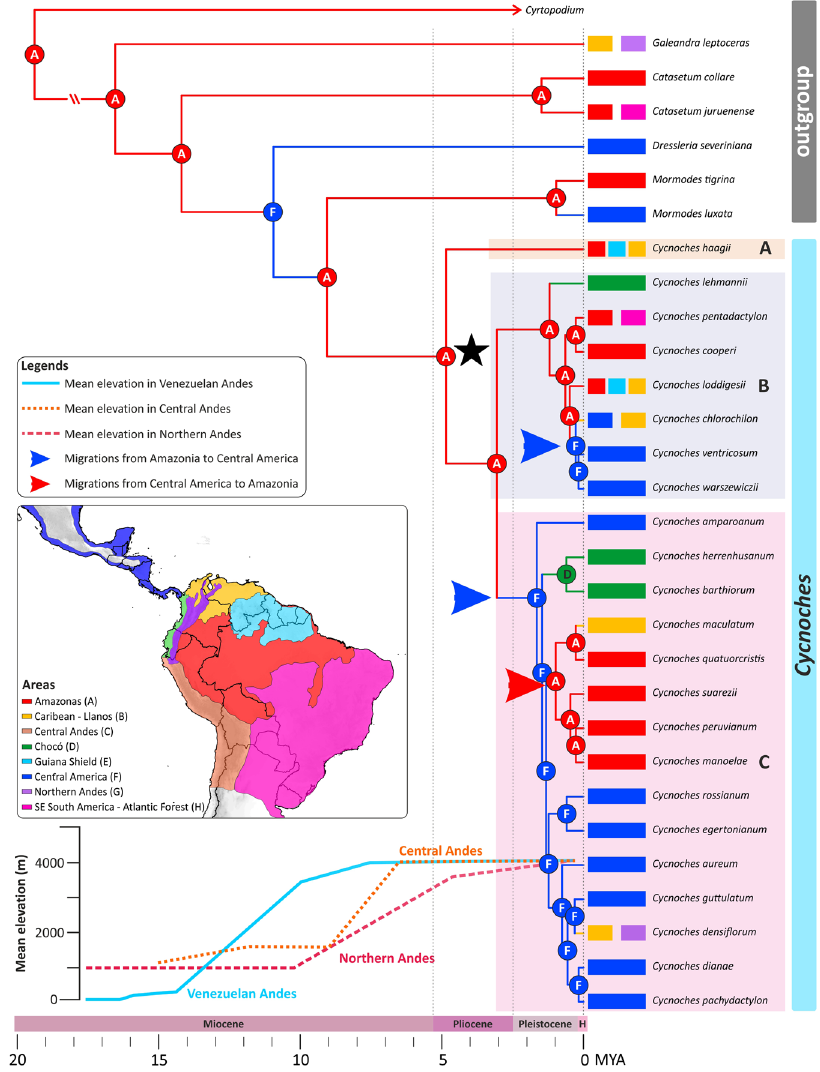
Figure 3. Chronogram for Cycnoches obtained under a relaxed clock model, applied to a non-conflicting, concatenated nuclear (ITS, ETS, Xdh ) and plastid loci ( trn S– trn G, ycf 1). Age estimates, including maximum and minimum intervals for all nodes, are provided in Figure S4. Time scale is provided in million years ago (Mya). Node charts correspond to ancestral areas estimated under the BayArea-Like * model, including founder event process ( J ). Geographical distribution in coded biogeographical areas of sampled species is shown in front of tree terminals. Pink, orange, and blue lines indicate mean elevations (m) on Colombian, Central and Venezuelan Andes, respectively (adapted 7 ). (Inset) Coded areas used for biogeographical analysis. Geopolitical boundaries map generated by ArcMAP software (http://www.esri.com). Political divisions and elevation data from DIVA-GIS